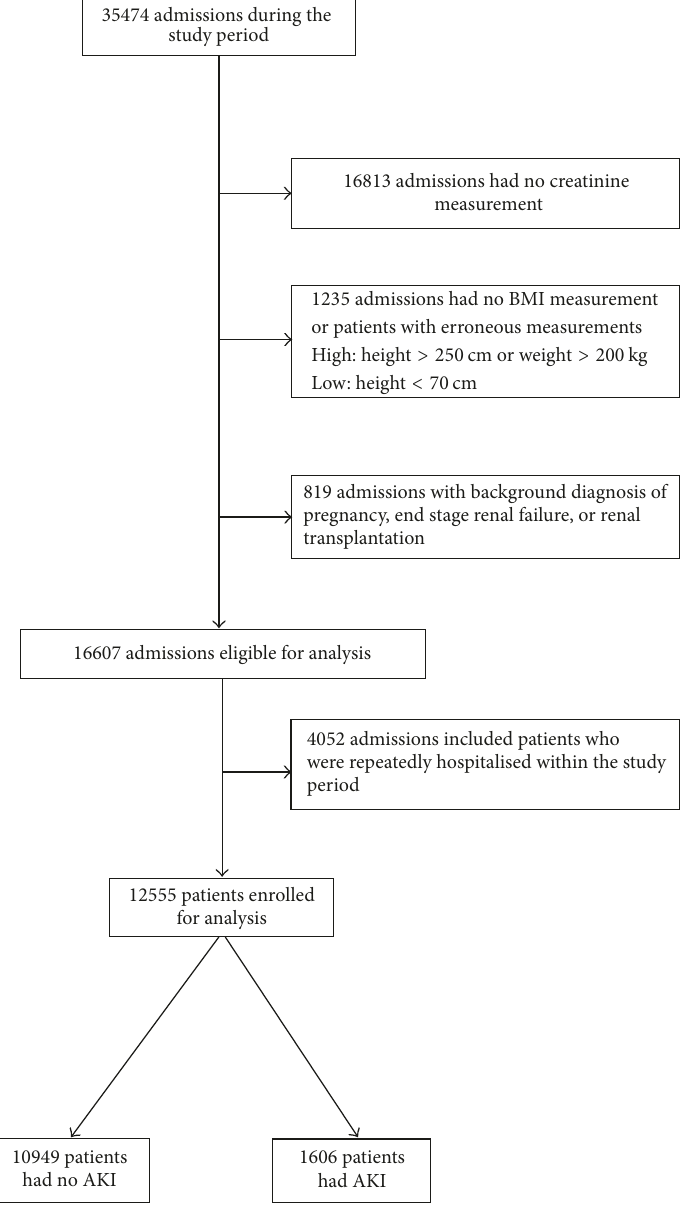
Figure 1: Flowchart of patient